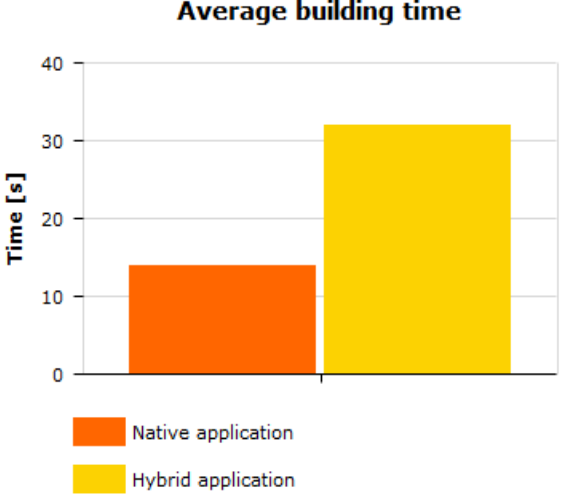
( b ) Figure 2. Project structure: ( a ) project’s disk space; ( b ) number of files and directories. It is obvious that if you can limit the number of files and the disk space usage, this allows you to reduce the memory resources needed by the device for the application itself. This means that, without increasing the cost of the device, more disk space or memory remains for the buffering of the received data from the sensors. 4.2. Build Time In the case of the native application, this process is performed by Gradle. It may be started in Android Studio IDE after choosing the Make Project or Build APK(s) options in the Build section in the top menu. Alternatively, a programmer can execute the command